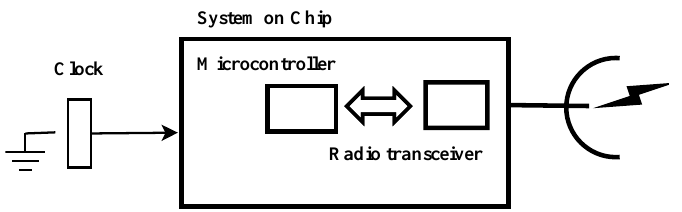
Figure 6. System on Chip: design of a mote with internal connection between the MicroController Units (MCU) and the radio